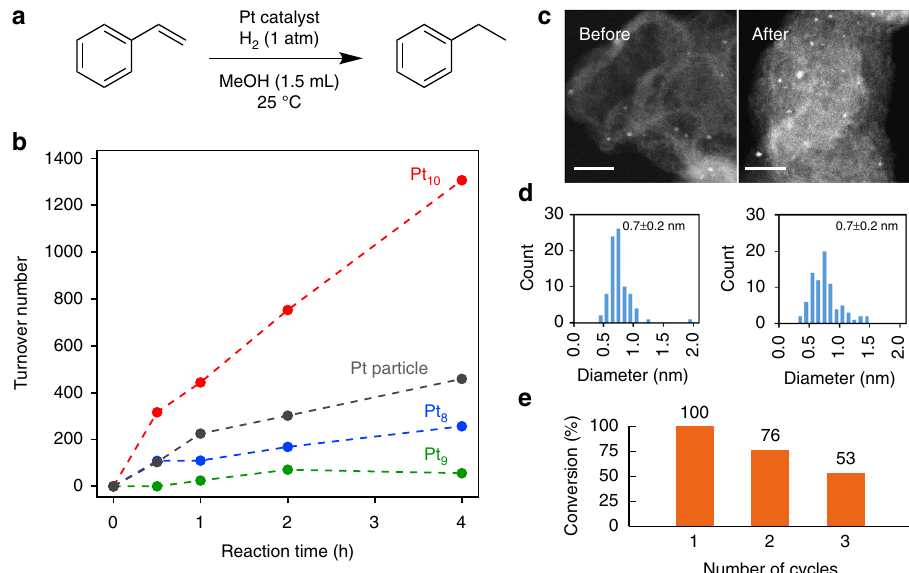
Fig. 3 Hydrogenation reaction of styrene catalyzed by platinum clusters. a A scheme of the conversion. b Turnover numbers of the styrene conversion catalyzed by platinum clusters (Pt 8 , Pt 9 , and Pt 10 ) on Ketjenblack (Pt: 0.02 mol%). Pt particle represents the platinum nanoparticles (1.1 ± 0.2 nm) prepared from [Pt( µ -SC 8 H 17 ) 2 ] 9 at higher concentration (1.8 wt% Pt) on Ketjenblack. c HAADF-STEM images of the Pt 10 catalyst before and after (2 h) the hydrogenation reaction. Scale bar , 10 nm. d The particle size histograms from the images on panel c and other views. e Styrene conversions at the end of the cycles during repeated uses of Pt 10 /KB. The reaction conditions are the same as those in panel b , but the amount of catalyst (Pt: 0.1 mol%) is